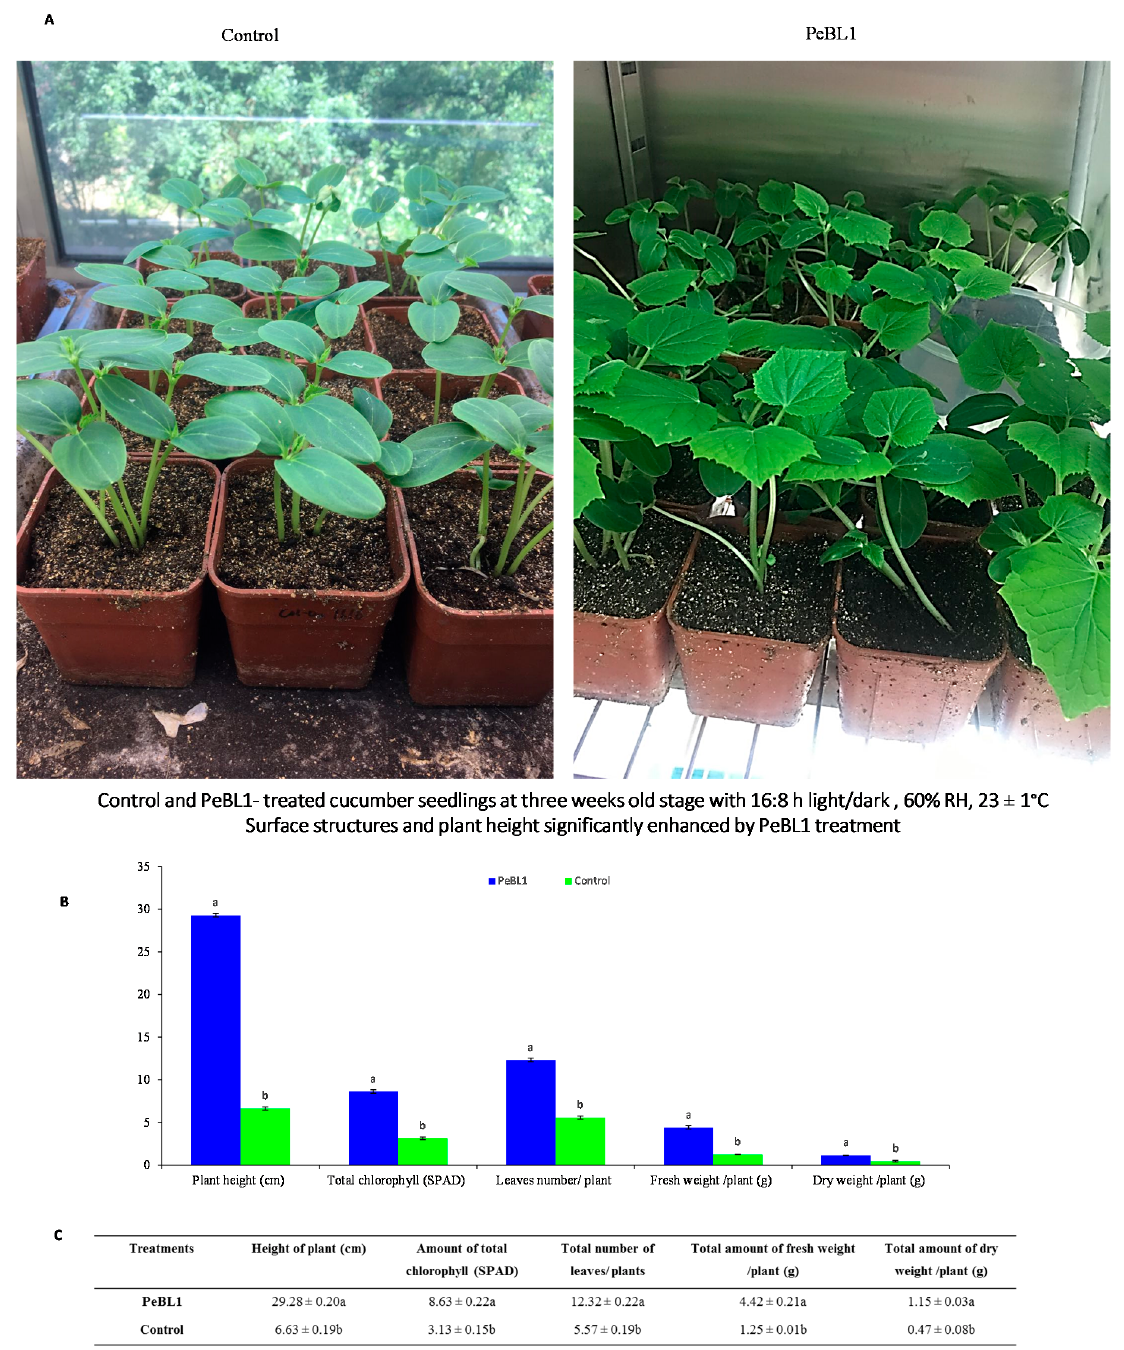
Figure 6. Influence of PeBL1 on the growth of PeBL1-treated and control cucumber seedlings. ( A ) Plant height increased in PeBL1-treated cucumber seedlings as compared to control ( B ) Physical characteristics of PeBL1-treated seedlings enhanced as compared to control ( C ) Data were shown in mean ( ± SD) of cucumber plants in PeBL1-treated and control seedlings (n = 10). Data were compared statistically by one-way analysis of variance (ANOVA) and Least signi fi cant difference (LSD) in Statistix 8.1 version. Different lower style alphabets letters indicate significant differences among treatments (P=0.05).